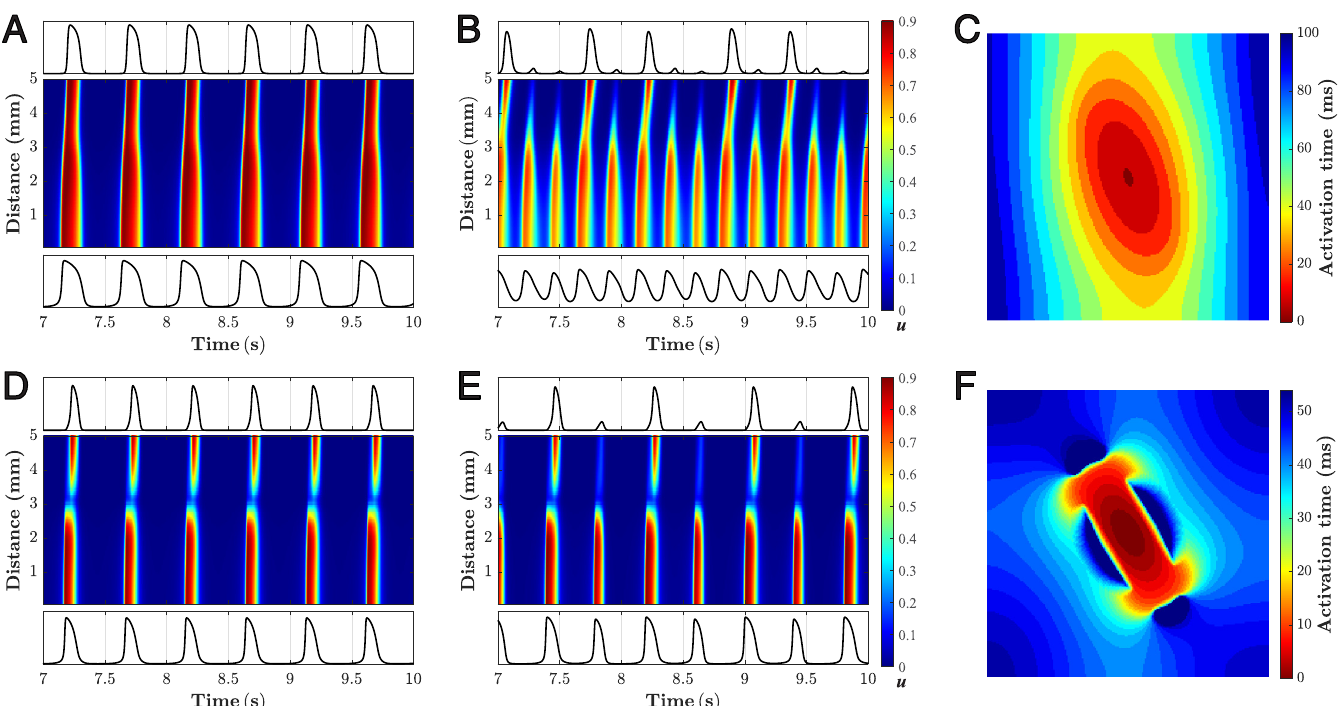
Fig 8. 2D simulation of SAN. Calculated time sequences of the transmembrane potential u along the bold black line in Fig 3A and activation sequences for SAN structure without (A–C) and with (D–F) walls of passive tissue. A. For diffusion coefficient D = 0.090 mm 2 ms -1 . B. D = 0.048 mm 2 ms -1 . C. Activation sequence corresponding to the case shown in panel A. D. D corresponding to the case shown in panel D.